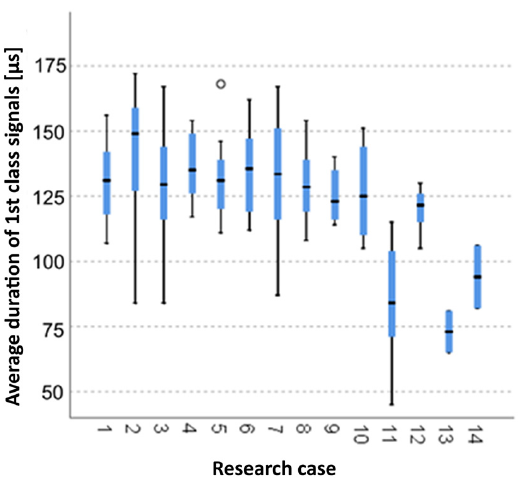
Figure 18. The graphical representation of the Kruskal–Wallis test results for independent tests of the average duration of the class 1 signals.